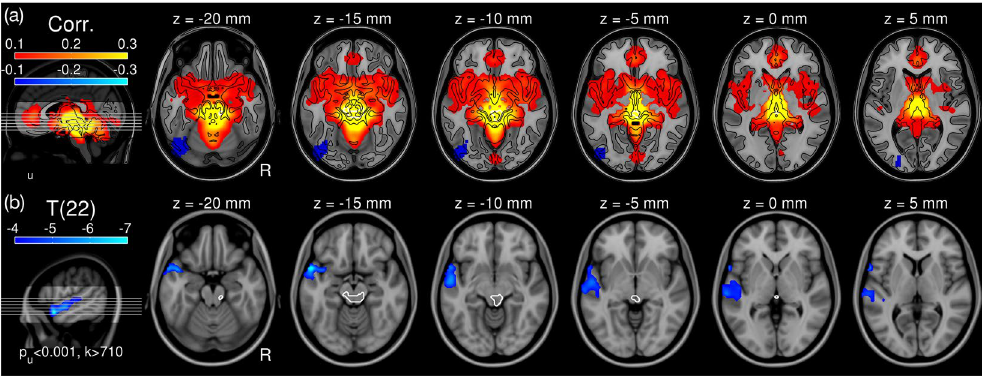
Figure 3. Functional connectivity of the right interior colliculus (IC). ( a ) Pearson’s correlation map seeding from the IC. For visualisation, tissue boundaries are marked in black contours. ( b ) T-map (d.f. = 22) for psychophysiological interaction between the psychological contrast (dissonant vs. consonant music) and the BOLD time series in the IC, which is marked in white. Family-wise error rate (FWER) was controlled to be less than 0.05 by cluster-extent thresholding. Abbreviation: d.f., degrees of